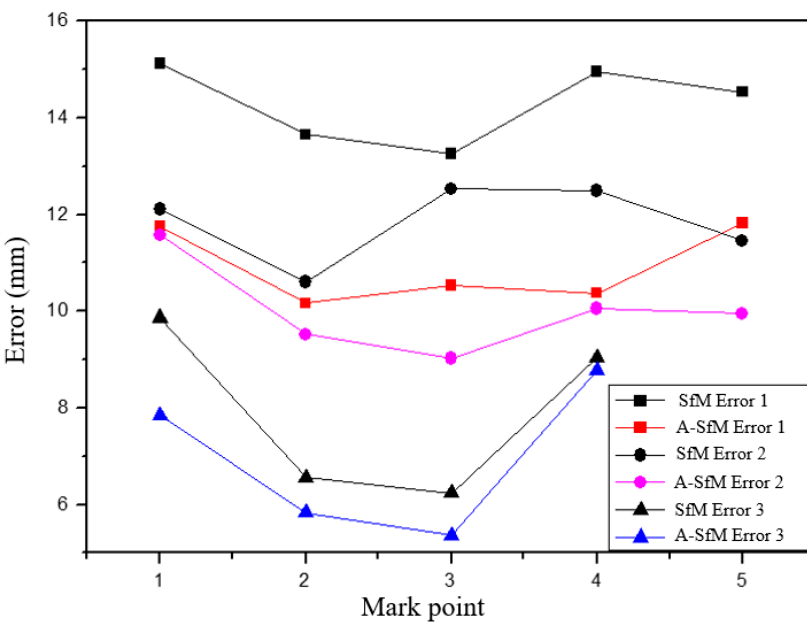
Figure 11. The reconstruction errors of the three groups of tests.